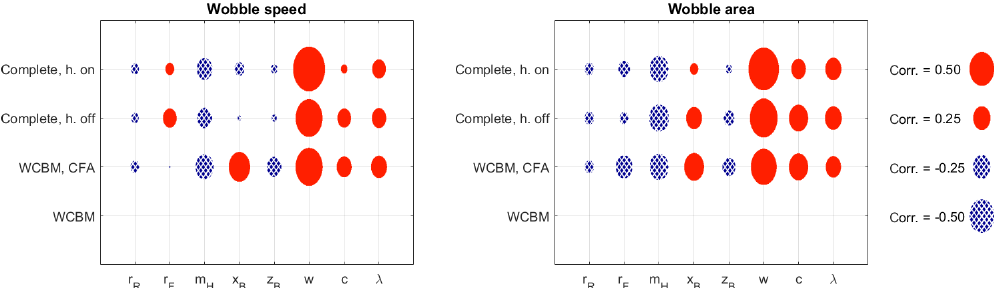
Figure 13. Correlation coefficients for the indices of the wobble mode. Models of increasing complexity from bottom to top. Speed range: 0 to 10ms − 1